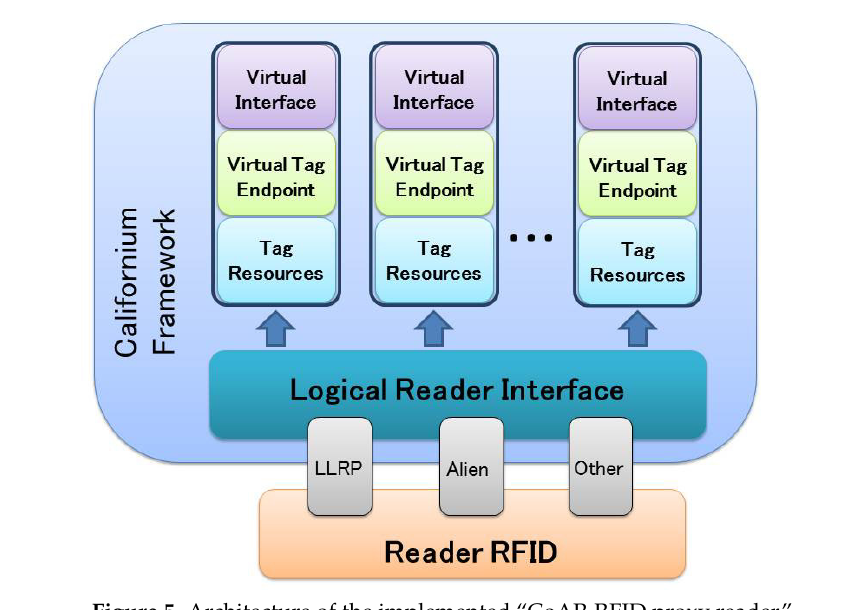
Figure 5. Architecture of the implemented “CoAP-RFID proxy